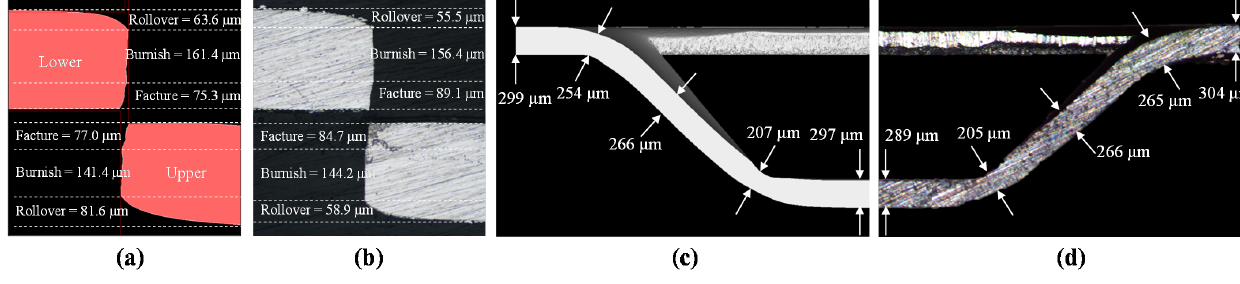
Figure 8. Comparison of deformed shapes in cross section view via ( a ) FE analysis with critical damage value of 3.6 and ( b ) experiment at forming height of 408 μ m; ( c ) FE analysis with a critical damage value of 3.6 and ( d ) experiment at forming height of 1.63 mm.